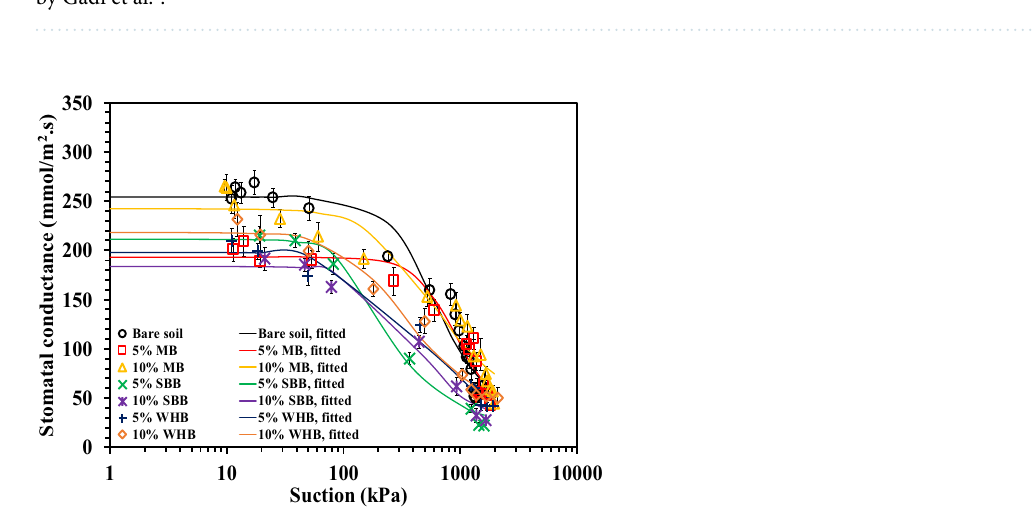
Figure 9. Variation of SC with suction in different